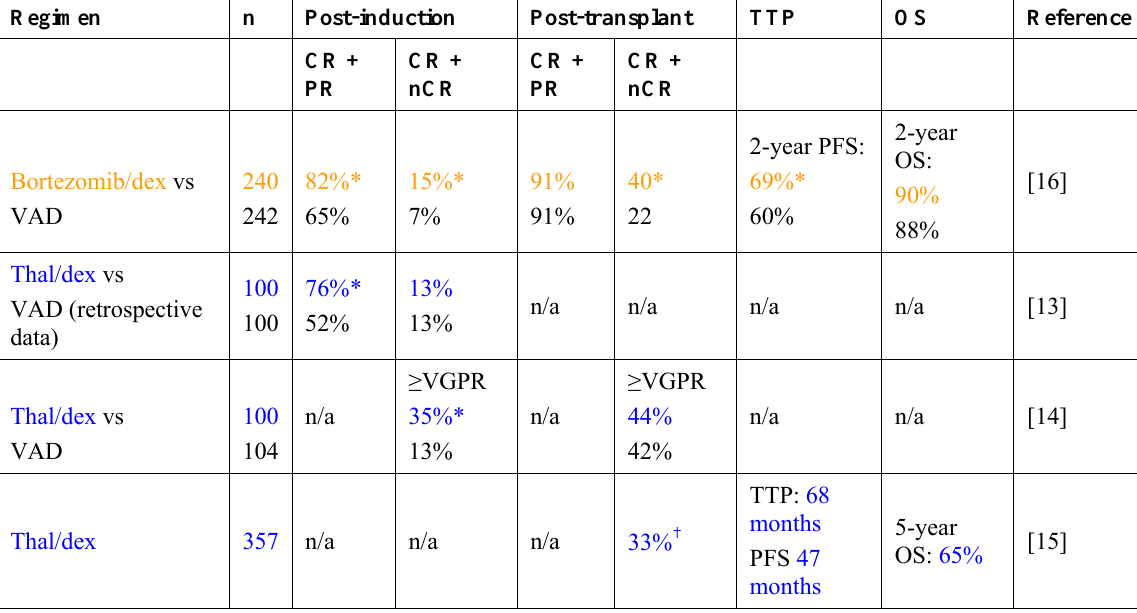
Summary of data for recommended induction regimens: thal/dex and bortezomib/dex.